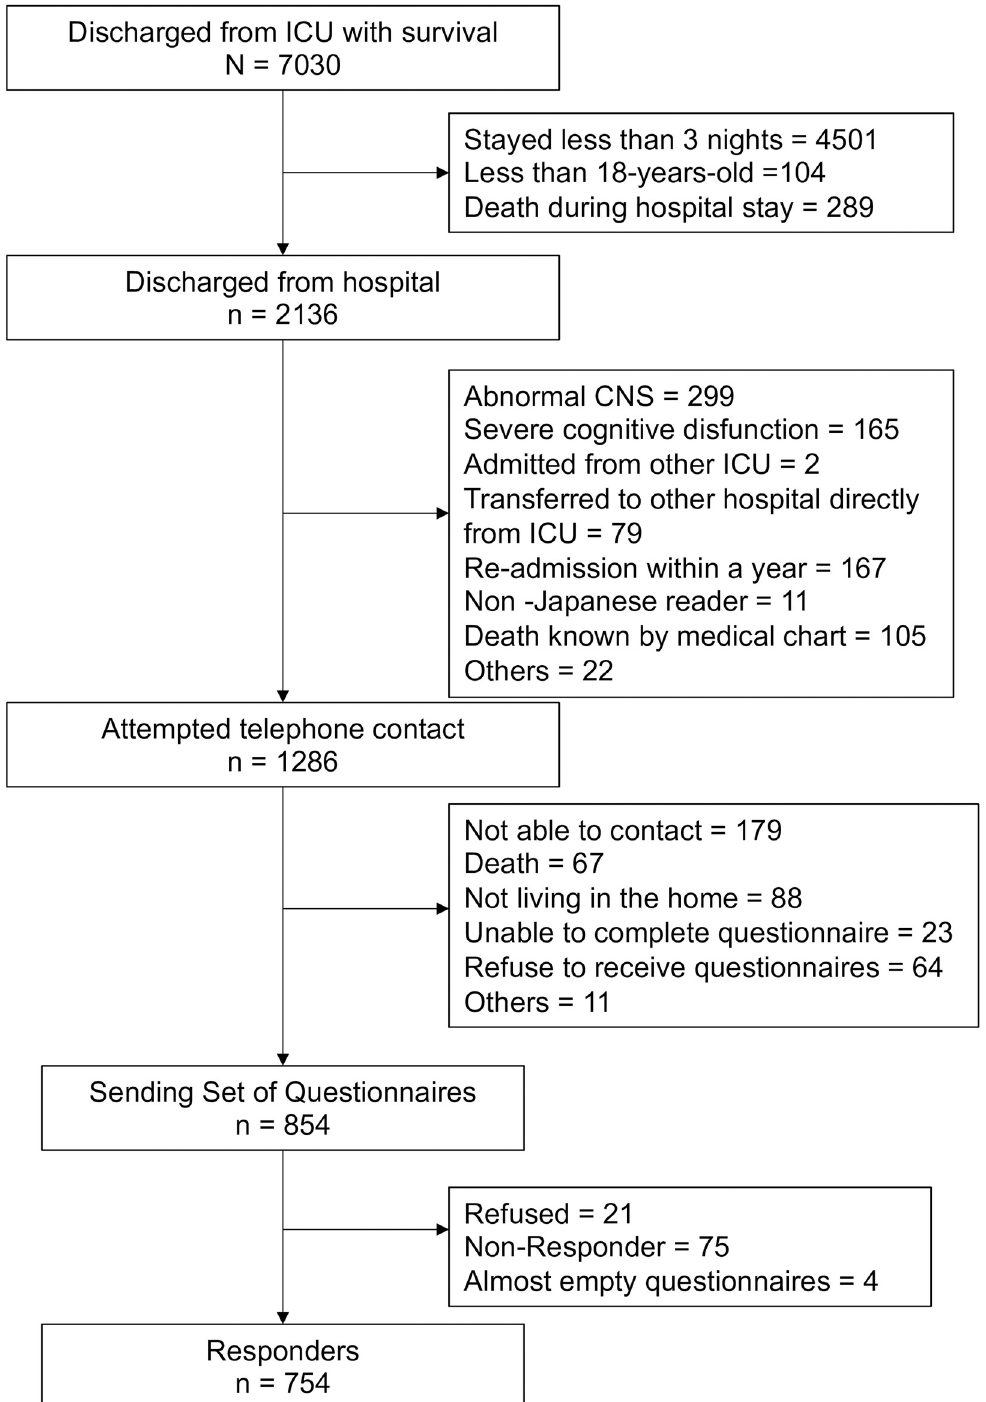
Fig 2. Patient recruitment flowchart. ICU, intensive care unit; CNS, central nervous system.